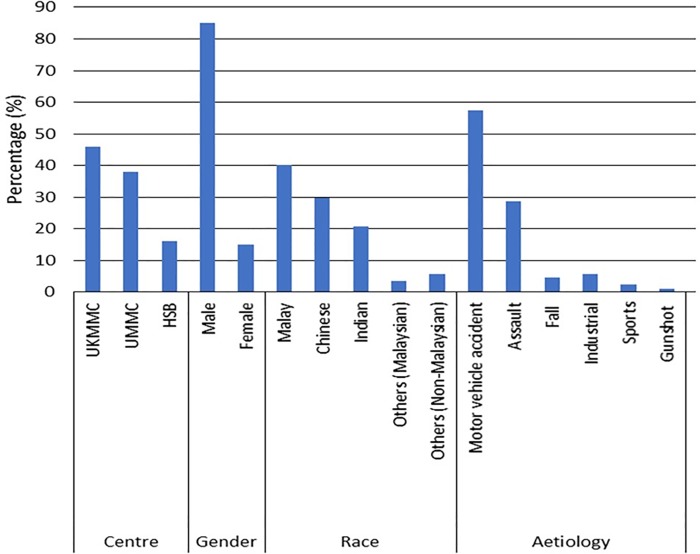
Demographic factors and etiology of pure orbital fractures.Fig 5 showing descriptive statistics (in percentage) for the occurrence of pure orbital blow out fractures in each hospital and according to race, gender and etiology.